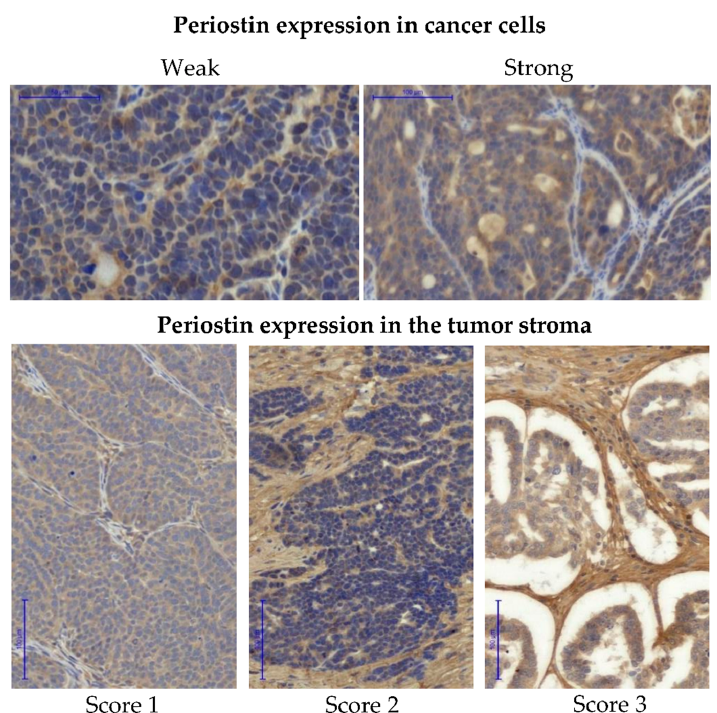
Figure 5. Immunohistochemical detection of periostin. Periostin expression was evaluated separately in cancer cells (upper panel) and in the tumor stroma (lower panel). Images show IHC staining in cancer cells scored either as “weak” or “strong” and IHC staining of stromal periostin scored 1–3. Pannoramic 250 Flash II Scanner, scale bar: 50 µm and 100 µm.